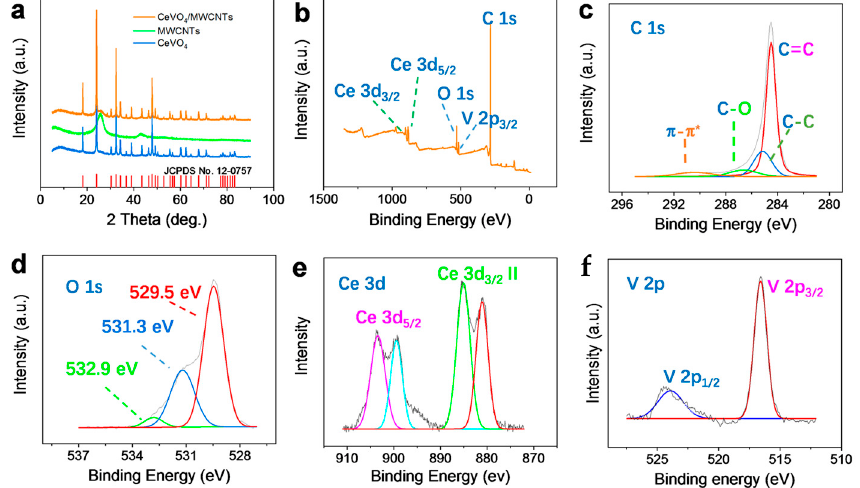
Figure 2. Structural characterization. ( a ) XRD patterns of CeVO 4 , MWCNTs, and CeVO 4 /MWCNTs. ( b ) XPS survey spectrum of CeVO 4 /MWCNTs. ( c – f ) Deconvoluted C 1s, O 1s, Ce 3d, and V 2p XPS spectra of CeVO 4 /MWCNTs.